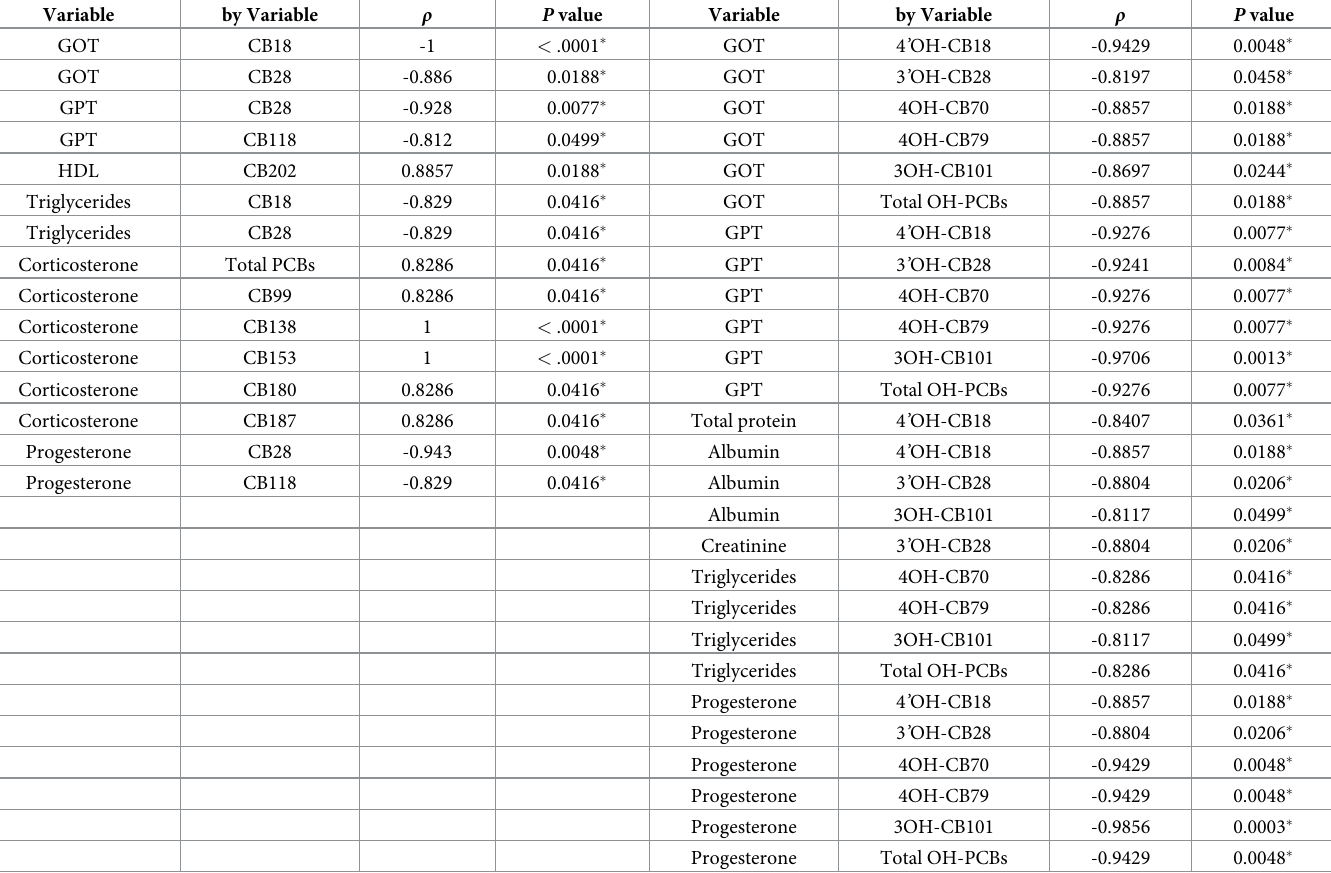
Table 2. Significant correlations ( P < 0.05) and Spearman’s rank correlation coefficients ( ρ values) between the biochemical parameters and PCBs or OH-PCBs in the serum of PCB-treated cats.